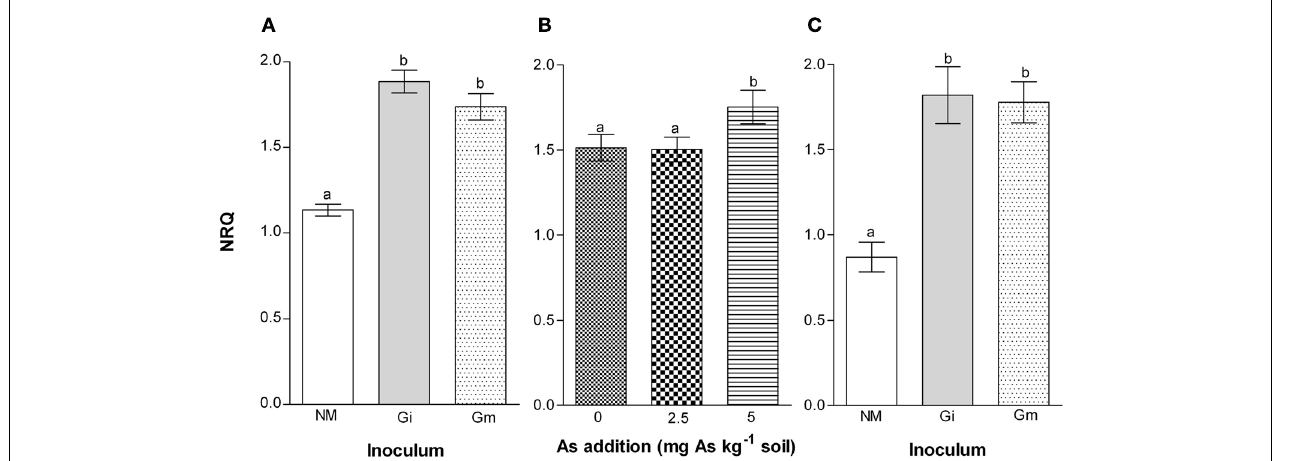
mosseae , Gm, stippled bars) on expression of both MtACR and MtPCS ( P = 0.0001). (B) shows effect of As application on MtACR ( P = 0.003).There were no effects of P application on expression of either gene. Data are presented as mean values ± SEM ( n = 5, except for treatment group NM, HP5As where n = 3). Same letters indicate no significant difference between treatment groups at the 5%